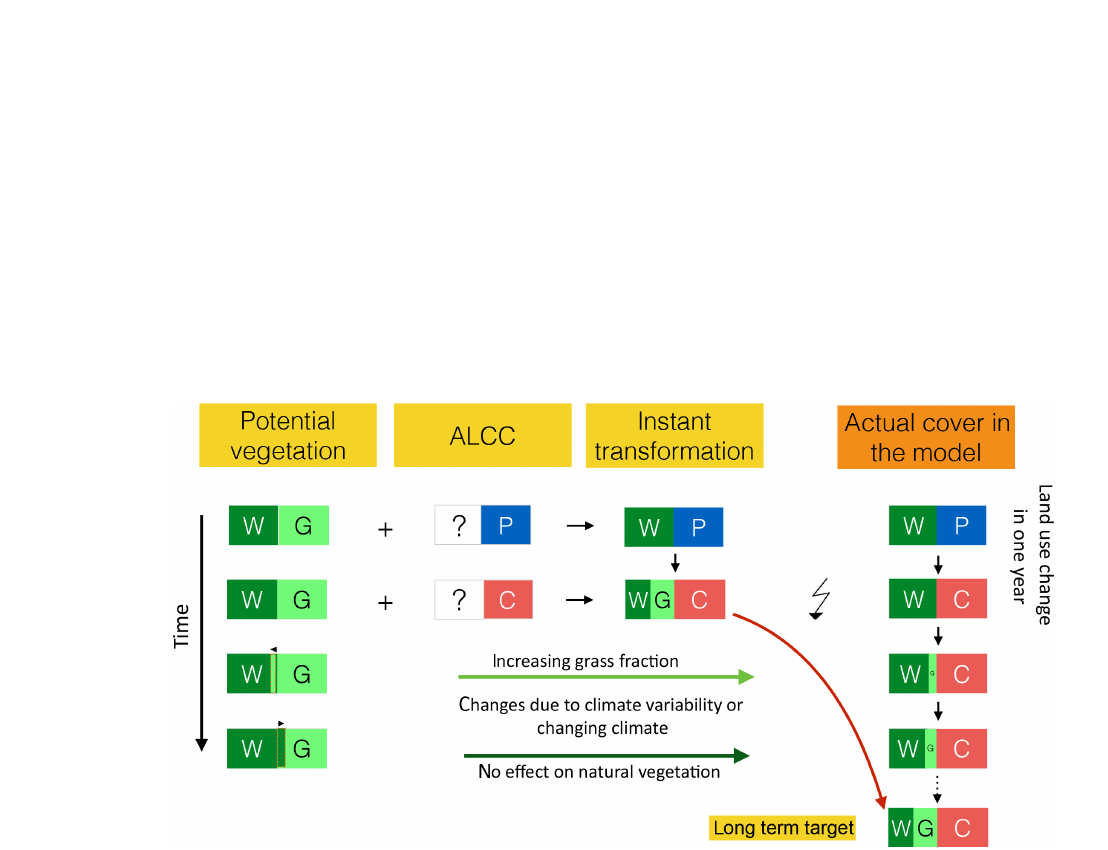
Figure A1. Diagram to illustrate the legacy effect of long-term changes in natural vegetation (G: grass; W: woody type) after strong an- thropogenic land use transitions (P: pasture; C: crops). Shown are the potential vegetation (model internal) which is in equilibrium with the current climate; the prescribed transition; the instant transformation of the left two pieces of information into a grid cell; and the actual, simulated cover (right column), which accounts for slow changes between two successive years within the natural